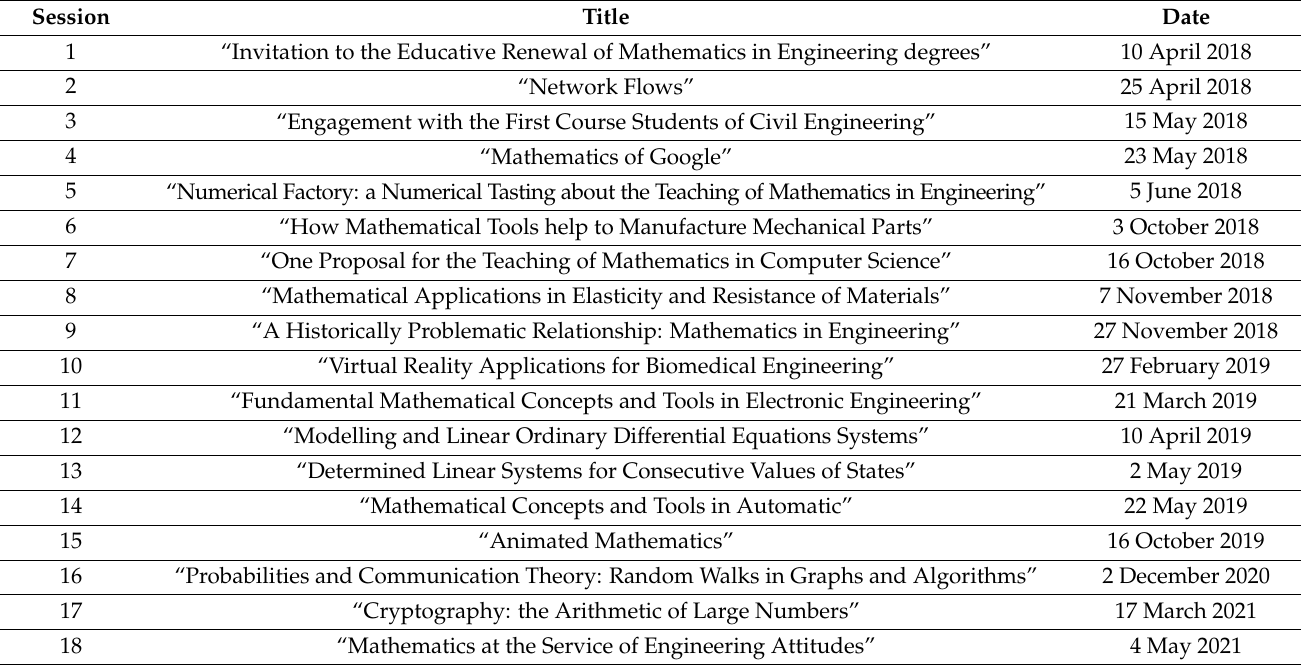
Table 1. Seminar of contextualization of mathematics in engineering